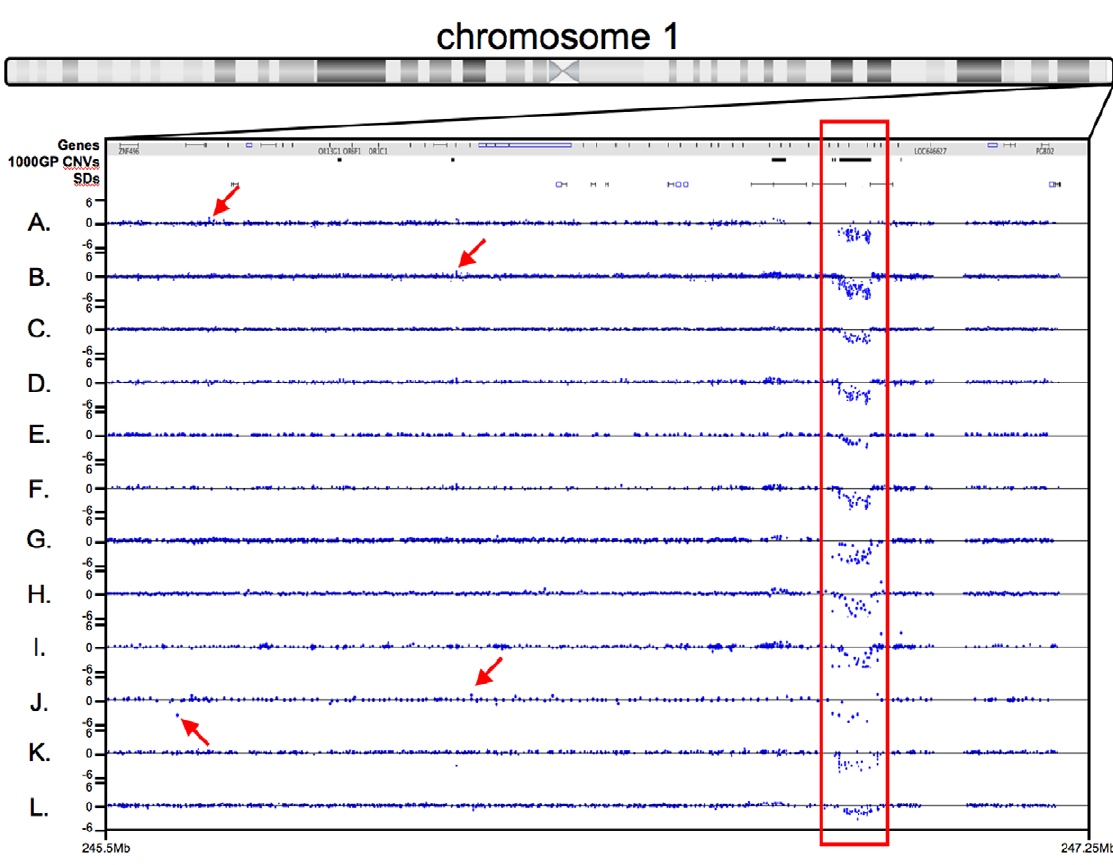
Figure 1. Detection of a known 57 kb CNV on chromosome 1q44 by twelve different array platforms. Depicted are the log 2 ratios of NA12878 to the control genome and locations along the chromosome for each probe (blue dot) in this region. Gene, 1000 Genomes Project Gold Standard CNVs (1000GP CNVs) and Segmental Duplication (SD) tracks are shown. The CNV highlighted in the red box was called by both replicates for all twelve platforms using the manufacturer-recommended software and parameters. Red arrows indicate examples of additional array-specific CNV calls. A. NimbleGen 4.2 M Whole Genome, B. NimbleGen 4.2 M CNV, C. NimbleGen 2.1 M Whole Genome, D. NimbleGen 2.1 M CNV, E. NimbleGen 3 6 720 K Whole Genome, F. NimbleGen 3 6 720 K CNV, G. Agilent 1 6 1 M CGH, H. Agilent 1 6 1 M High Resolution, I. Agilent 2 6 400 K CNV, J. Agilent